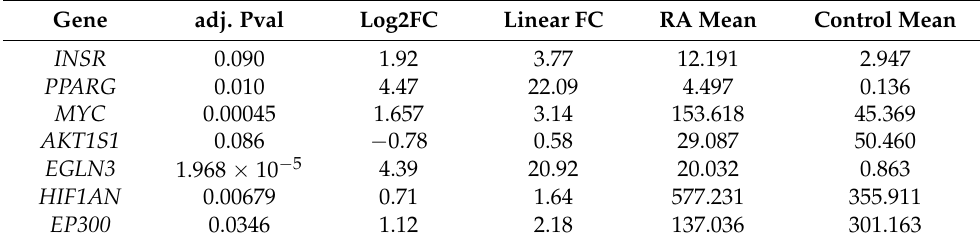
Table 21. The differentially expressed genes in RA CD8 + Temra cells that are involved in the regulation of glycolysis. Means are calculated from DESeq2 normalized counts.